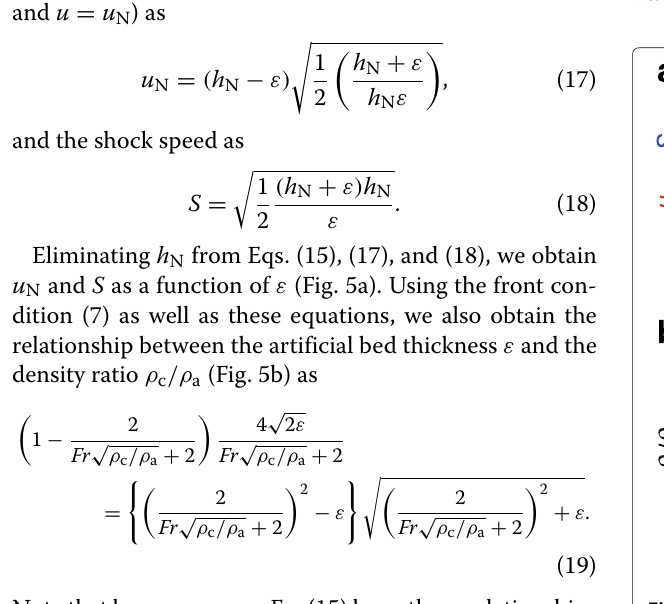
dition ( h = 1, u = 0) enter the front domain ( h = h N , u = u N ), we can obtain